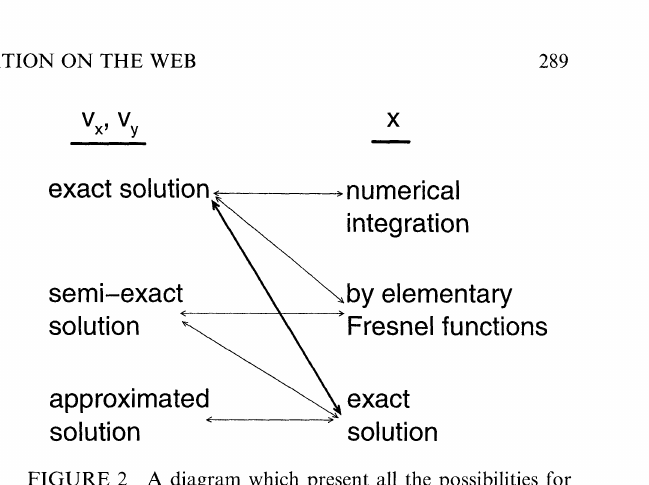
FIGURE 2 A diagram which present all the possibilities for the map construction. The wider line indicates the chosen